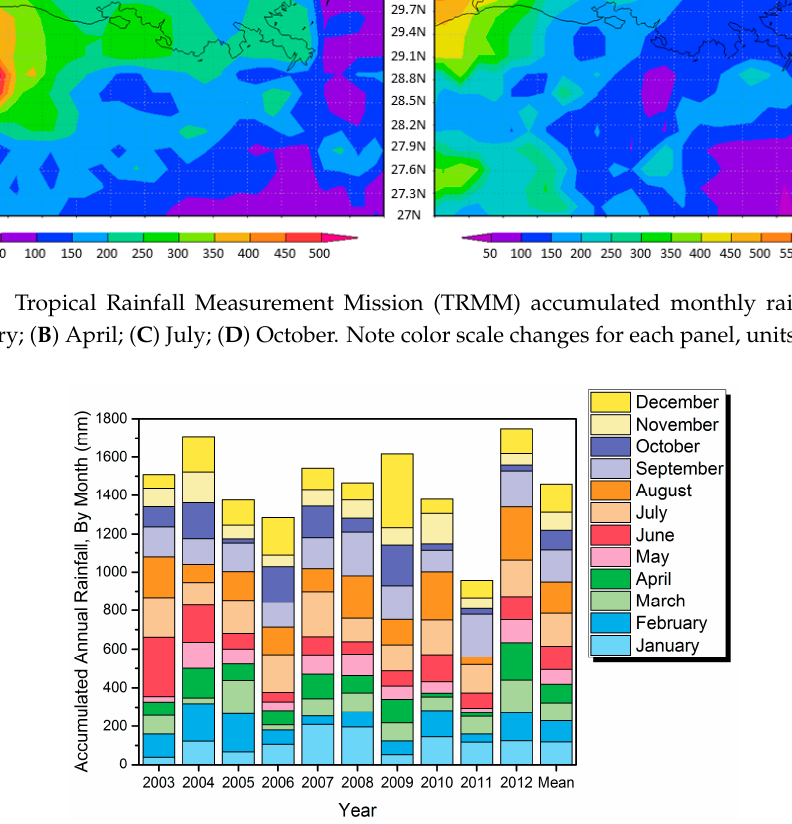
Figure 5. Monthly accumulated rainfall, averaged over the model domain, 2003–2012.